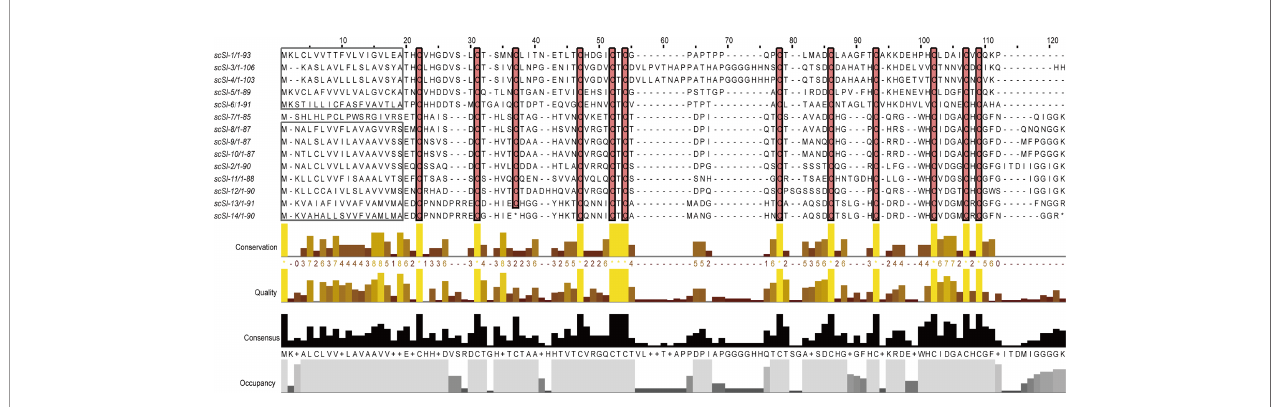
FIGURE 1 | Peptide sequence alignments of the fourteen Family I84 genes from razor clam, two formally characterized members scSI-1 and scSI-2 were included. Predicted signal peptide are framed, conserved cysteine residues are highlighted. Conservation and consensus were shown of the residues. * means the stop codon of peptide.